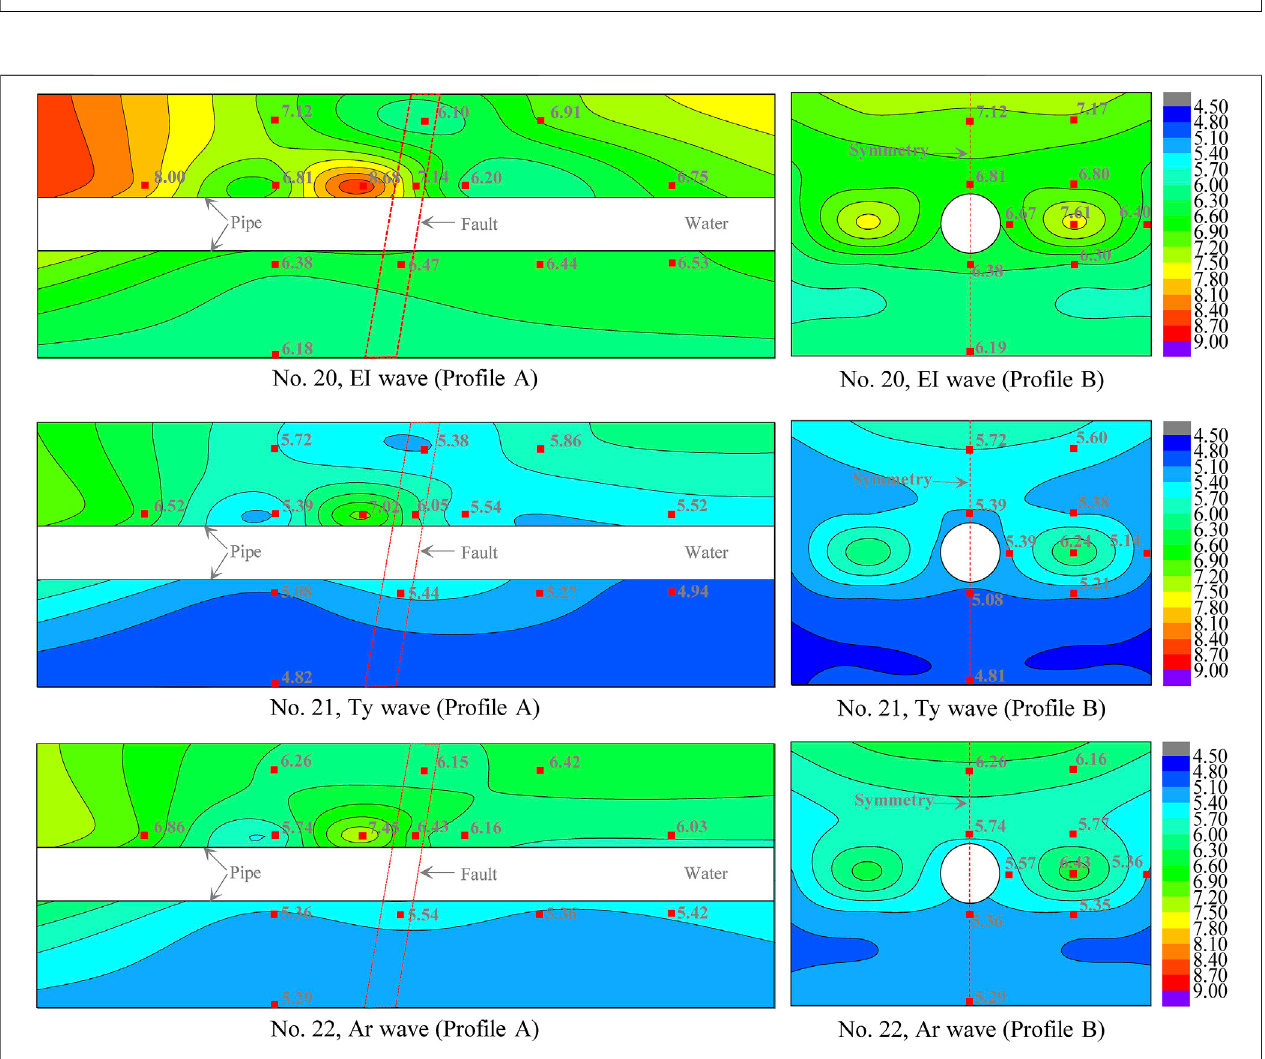
responsive stress time-history curves approximatively synchronize with that of the excitation acceleration for most monitoring points. The responsive stress amplitude generally